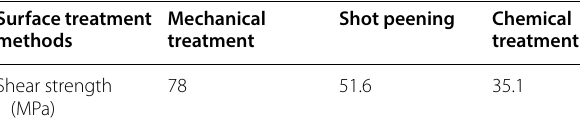
Table 1 Shear strength of three surface treatment